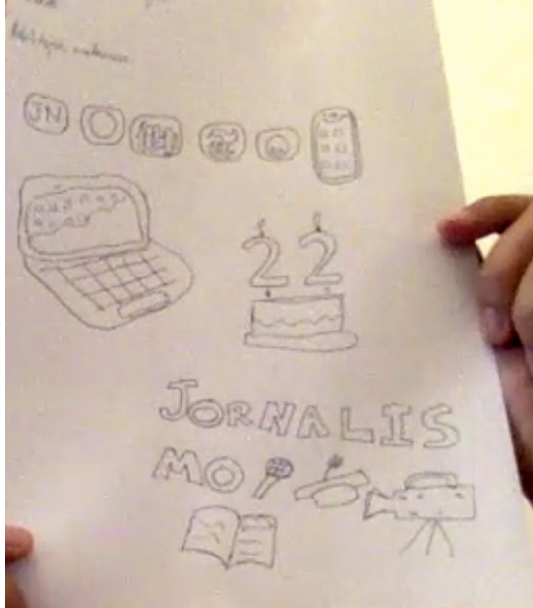
Figure 2. Rui’s (22) drawings on his (digital) media preferences. Note: The text in the drawing reads “journalism.” that, in her opinion, it is possible to combine both worlds and the links created. As far as information consump‐ tion and research are concerned, both the